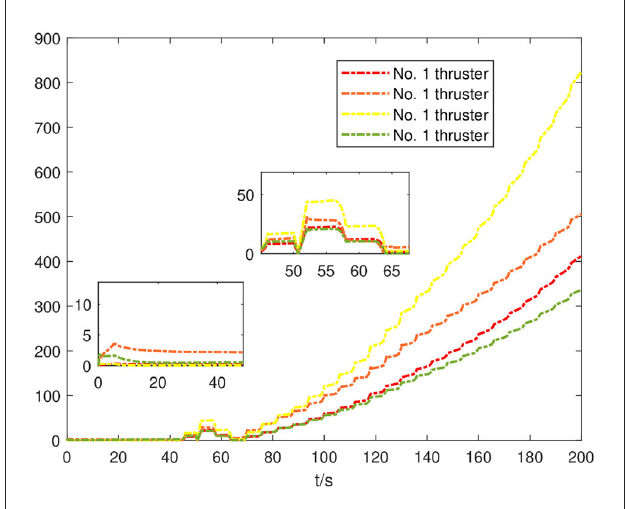
FIGURE9 Thruster output force.